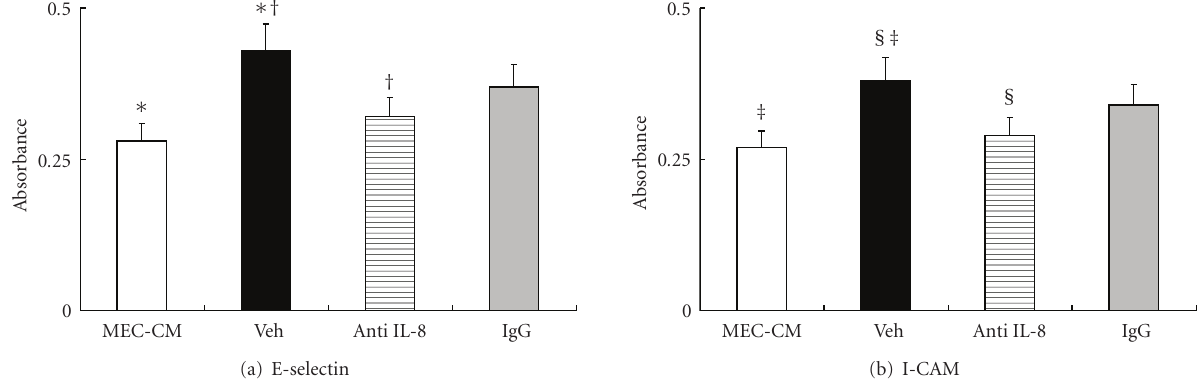
Figure 6: Changes of the expression of endothelial adhesion molecules (E-selectin and ICAM-1) by anti-IL-8 antibody. The expression of E-selectin and ICAM-1 on HUVECs were significantly increased in the 10SP/MEC-CM (Veh group) compared with the MEC-CM. The expression of E-selectin and ICAM-1 on HUVECs in 10SP/MEC-CM treated with anti-IL-8 antibody was significantly less than that in Veh group. ∗ , † , ‡ P < . 05, § P < .